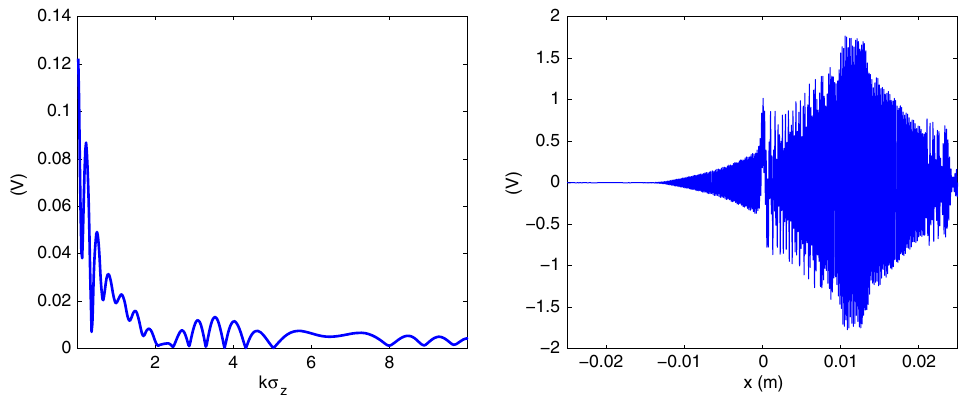
ˆ H k; s ; 0 ; g Þj as a function of k (left) and Z 0 ˆ H x ð b